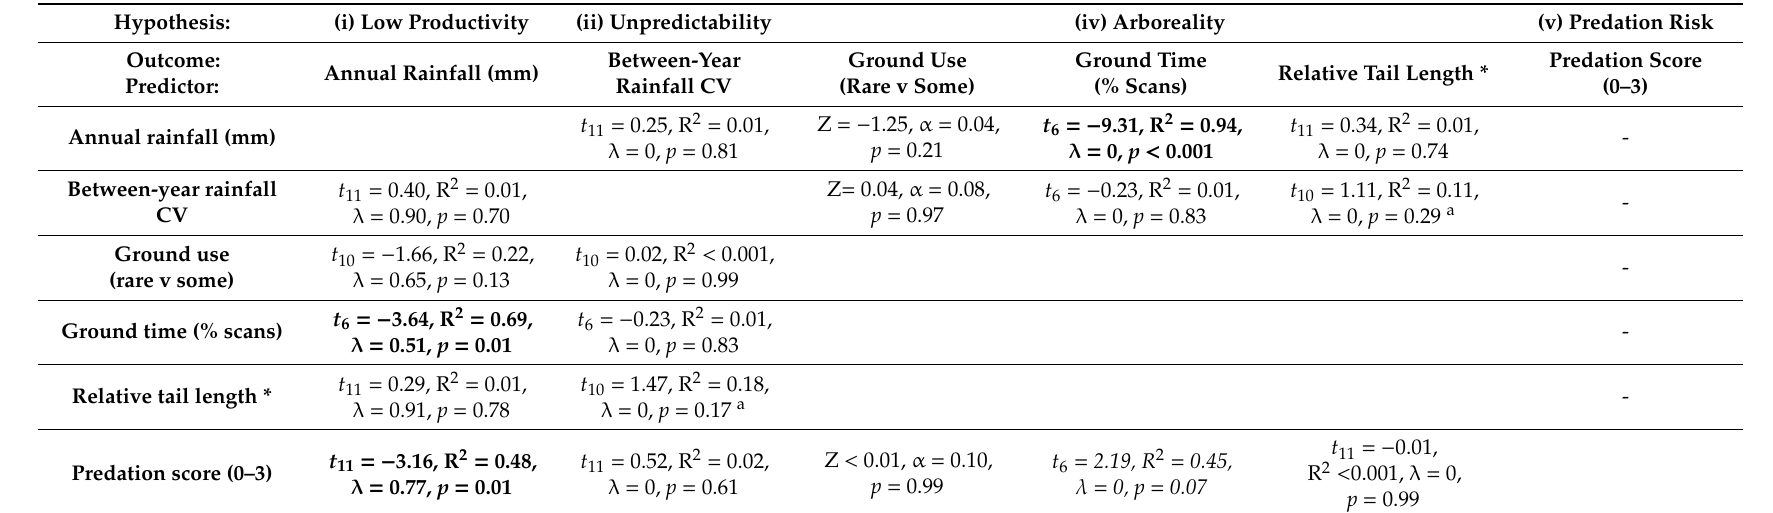
Table A2. Results of models investigating potential relationships among predictor variables belonging to di ff erent hypotheses. PGLS models were used for continuous outcomes, and phylogenetic logistic regression was used to analyse ground use as an outcome. CV = coe ffi cient of variation. Dashes indicate that the analysis could not be performed (because neither PGLS nor phylogenetic logistic regression models are appropriate for ordinal outcome variables like predation risk). Results in bold were considered significant at p < 0.05, and trends ( p < 0.10) are italicised. All p values are